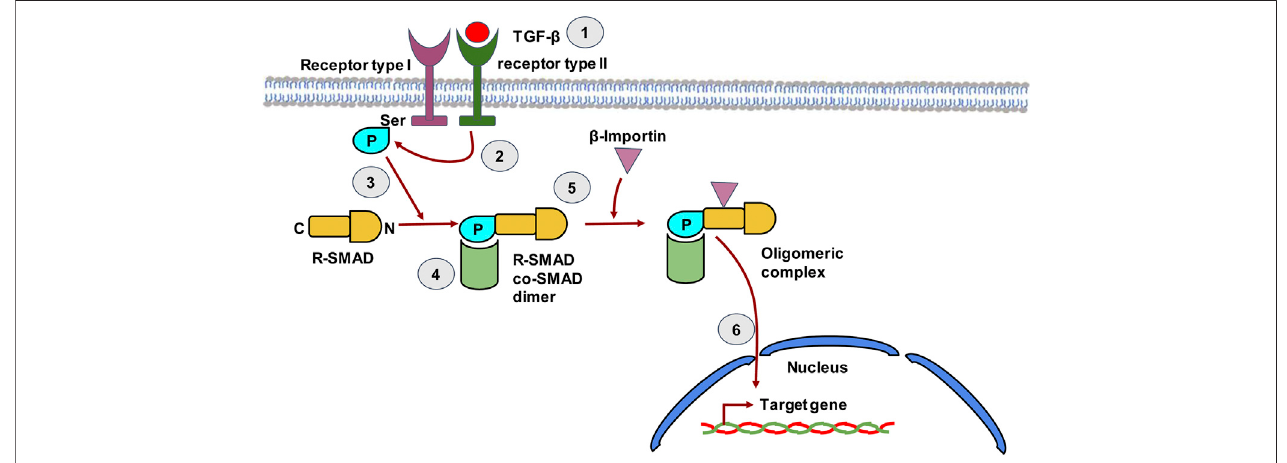
FIGURE4| TheTGF- β signalingpathwayinhepaticstellatecells.TGF- β bindstotypeIITGF- β receptorleadingtoreceptordimerizationi.e.recruitmentofthetypeI TGF- β receptor. The kinase domain of Type II TGF- β receptor then phosphorylates the Ser residue of type I TGF- β receptor. The phosphorylated receptor now recruits R-SMAD, which binds toreceptor through its N-terminalregion and gets phosphorylated by the Type II receptor. The C-terminalof R-SMAD has a DNA binding domain (DBD)thatcan act asatranscriptionfactor. Theco-SMADnow binds toR-SMADand β -Importinbinds tothe dimer forming an oligomeric complexthat guides the R-SMAD and Co-SMAD into the nucleus. The dimer enters the nucleus and the DBD of SMAD now acts as transcription factor that can transcribe target genes.